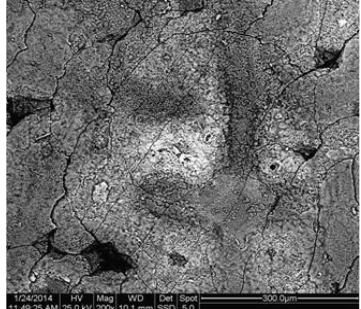
Figure 9. SEM backscattered electron image (×200) of TB detached patina (internal surface in contact with metal) after anodic polarization (OCP+ 1.5 V) in 0.1 mol/L NaCl solution.